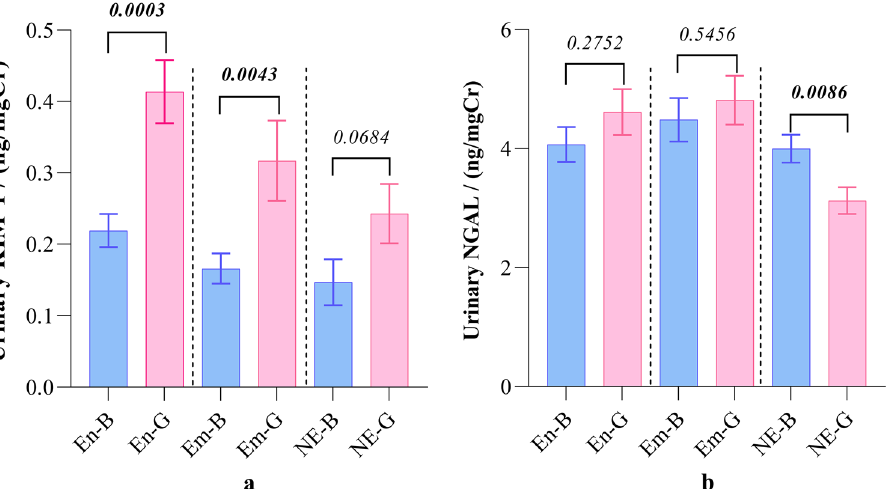
Figure 5. Expression of biomarkers in urine. ( a ) KIM-1 and ( b ) NGAL across gender in the three study groups. Graphs represent mean with standard error of mean (SEM). Comparison between the boys and girls within the same group is expressed in terms of Mann–Whitney U test. The study groups: En: endemic, Em: emerging, and NE: non-endemic regions. B: boys and G: girls. KIM-1: kidney injury molecule and NGAL: neutrophil gelatinase associated lipocalin.